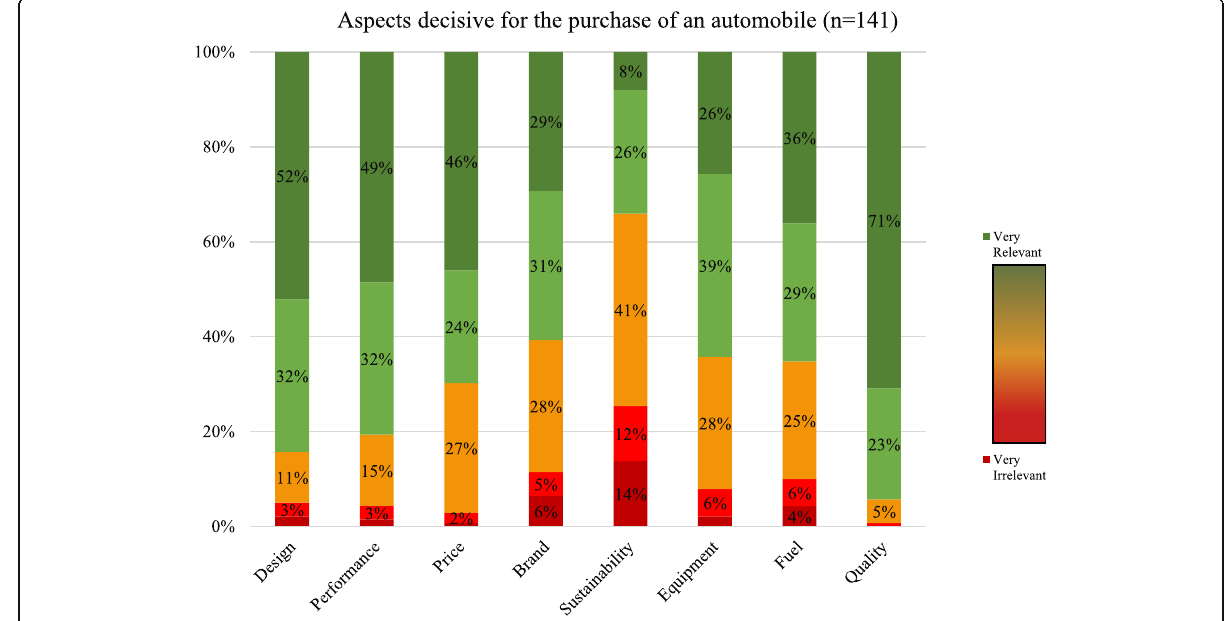
Fig. 2 Aspects decisive for the purchase of a passenger car. Source: Own